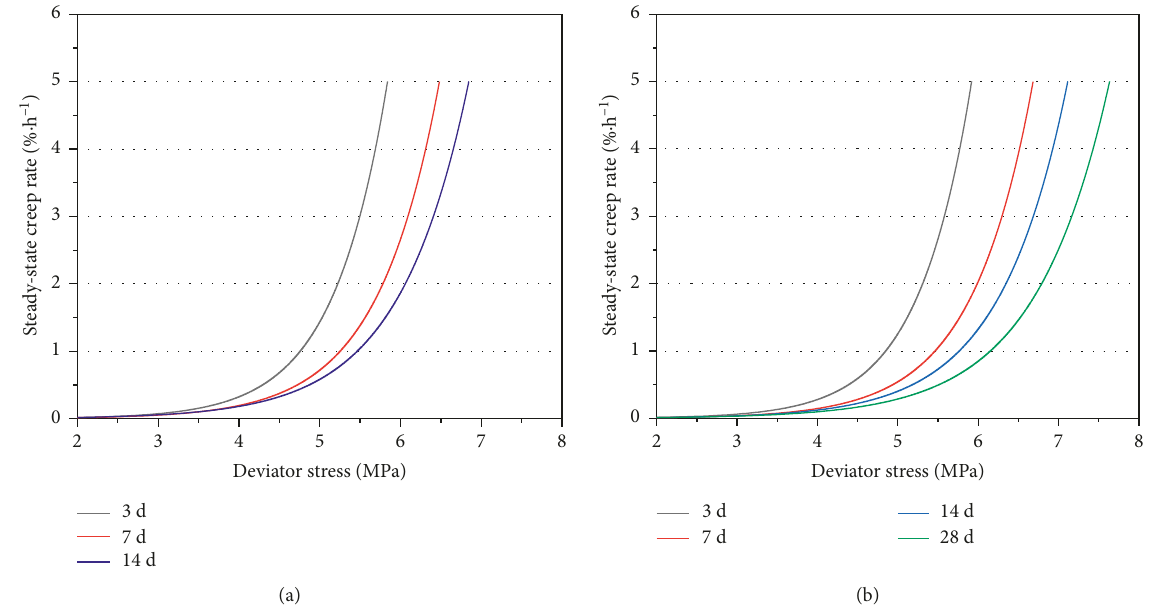
Figure 5: The regression curves of _ ε